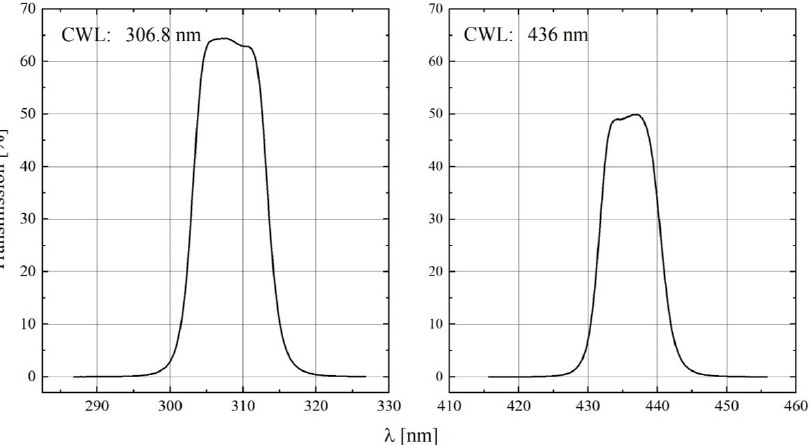
Figure 4. Wavelength-dependent transmission of the optical bandpass filter with a center wavelength of 306.8nm ( left ), and 436.0nm ( right )